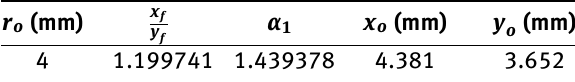
Table 3: Results of scaling the inlet dimensions